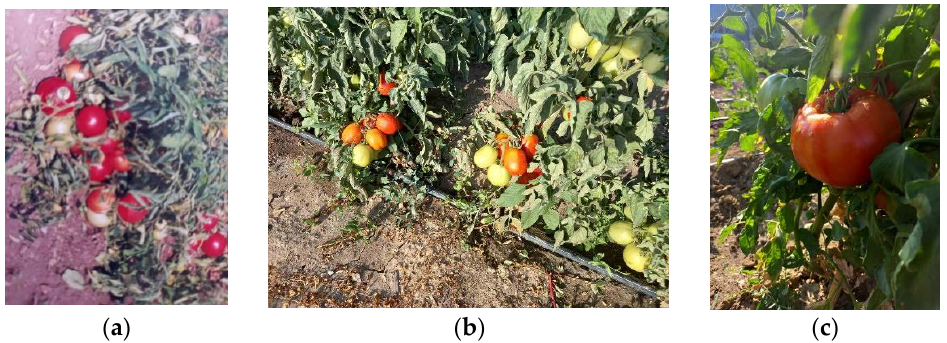
Figure 1. Sample images representing the different types of tomatoes used in this paper: ( a ) ‘local dwarf ’ , ( b ) ‘Pikador’ , and ( c ) ‘Ideal’ .